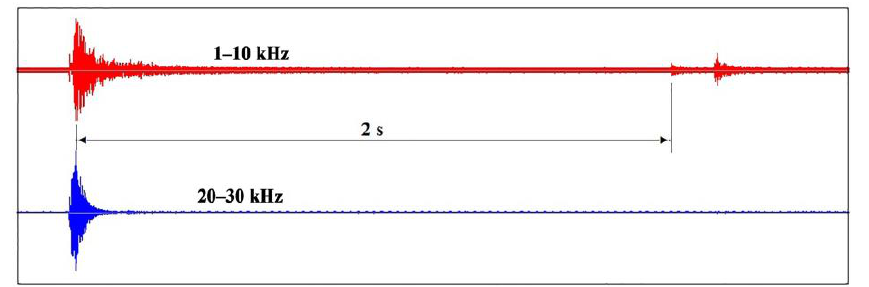
Figure 12. Registration of the moment of crack formation through recording of the VA signal in time in the frequency ranges of 1 – 10 and 20 – 30 kHz during irradiation of the M20 alloy with a discharge voltage of 20 kV.